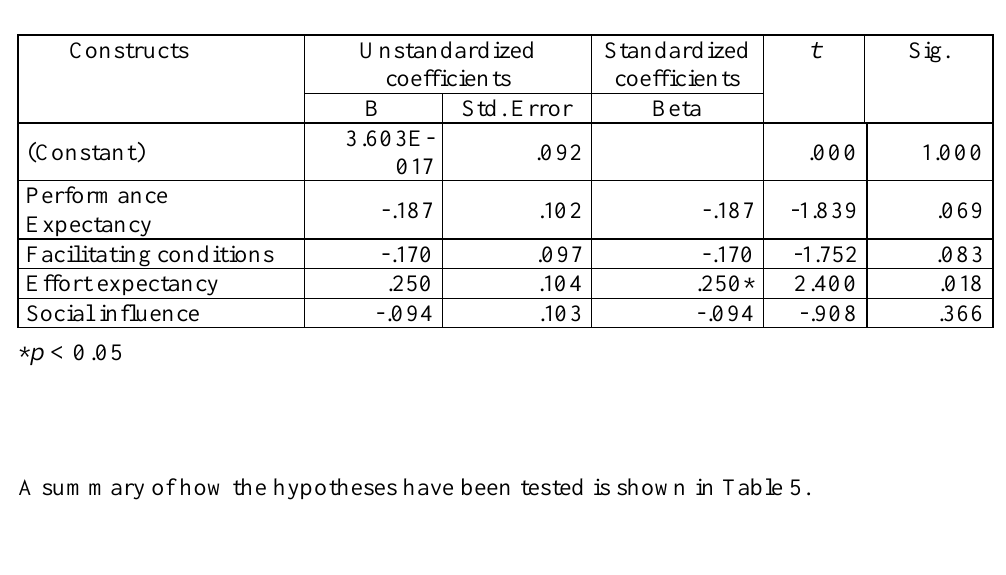
Unstandardized and Standardized Regression Coefficients for the Constructs Entered in the